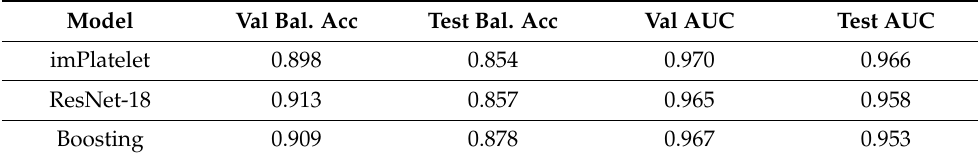
Table 5. Results of the experiment transfer to a new hospital.